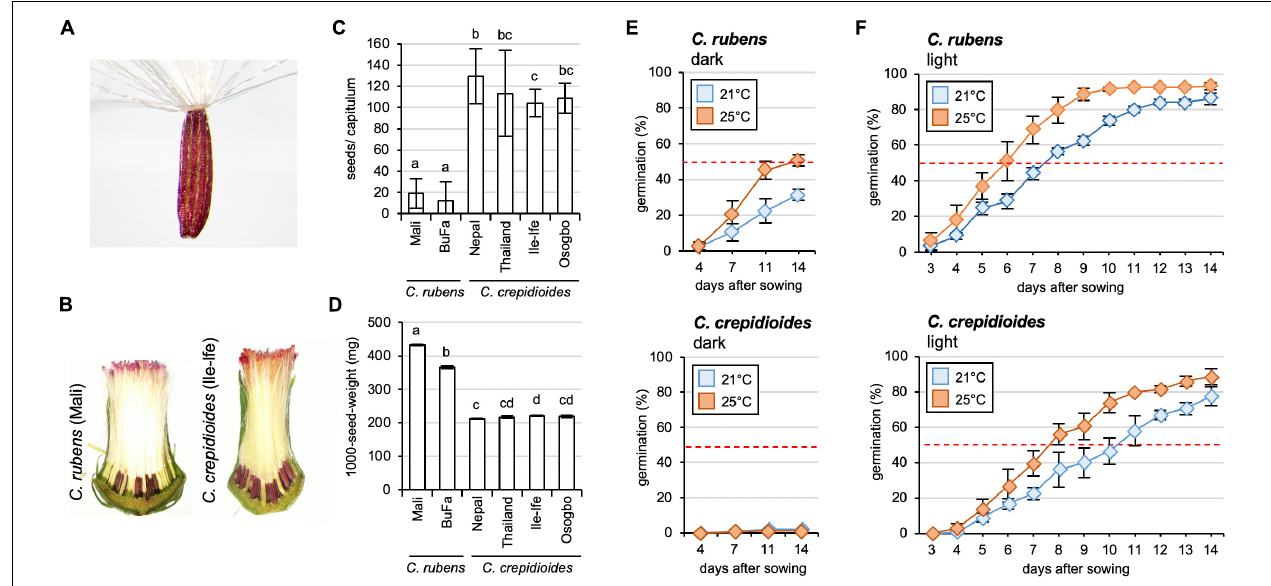
FIGURE 2 | Crassocephalum crepidioides forms more seeds than C. rubens , which exhibit a higher level of seed dormancy. (A) Seed of C. crepidioides with hairy pappus. (B) Seed development in capitula of C. rubens and C. crepidioides . Sections of representative capitula are shown. (C) The number of seeds/capitulum of different accessions of C. rubens and C. crepidioides , grown in the greenhouse at 16 h light/8-h dark cycles. Twenty capitula were evaluated and the mean and SD are shown. Different letters over the error bars indicate significant differences ( p < 0.05; ANOVA, post hoc Tukey). (D) One thousand-seed-weight of plants grown as in panel (B) (means ± SD; n = 4). Different letters over the error bars indicate significant differences ( p < 0.05; ANOVA, post hoc Tukey). (E,F) Seed germination of C. rubens and C. crepidioides in the dark (E) or in the light (F) . Fifty seeds of C. rubens Mali (top) and C. crepidioides Ile-Ife (bottom) were plated on 1/2 MS and incubated in either the dark or in 16-h 30 µ mol m − 2 s − 1 white light/8-h dark cycles at a temperature of 21 or 25 ◦ C, respectively. Seed germination, defined as radicle emergence from the seeds coat, was evaluated at the indicated time points. Data show the mean ± SD with n = 50.